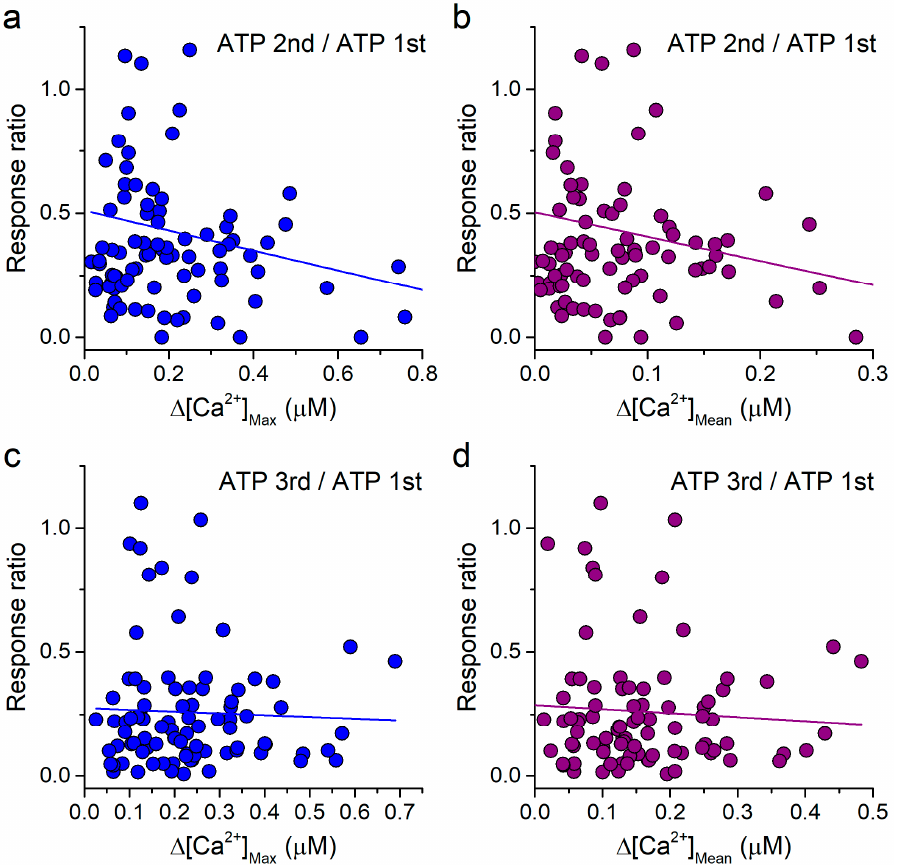
Figure 5. Lack of correlation between the reduction in the response to ATP and the increase in intracellular [Ca 2+ ] induced by SiNPs. ( a , b ) Plots of the ratio of the amplitudes of the responses to the 2nd and 1st applications of 10 µ M ATP versus the maximal increase ( a ) and mean increase ( b ) in intracellular [Ca 2+ ] induced by 100 μ g/mL SiNPs. ( c , d ) Equivalent plots to those shown in panels ( a ) and ( b ), but using the ratio of the amplitudes of the responses to the 3rd and 1st applications of 10 μ M ATP. The lines represent the corresponding linear fits, with R 2 values of 0.04, 0.04, 0.002 and 0.004, for panels ( a – d ), respectively.